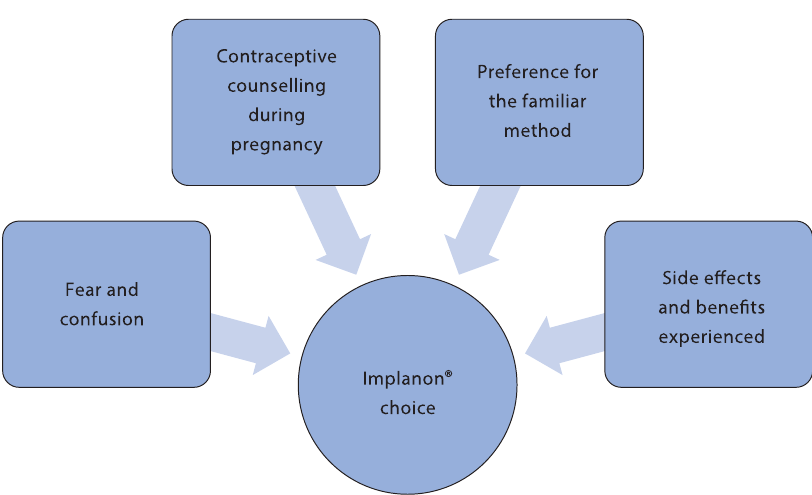
Figure 1: Factors in fl uencing women to choose or avoid